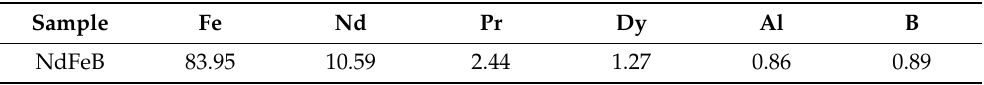
Table 1. Chemical compositions of the Zn-coated NdFeB sample used in this study (at.%).